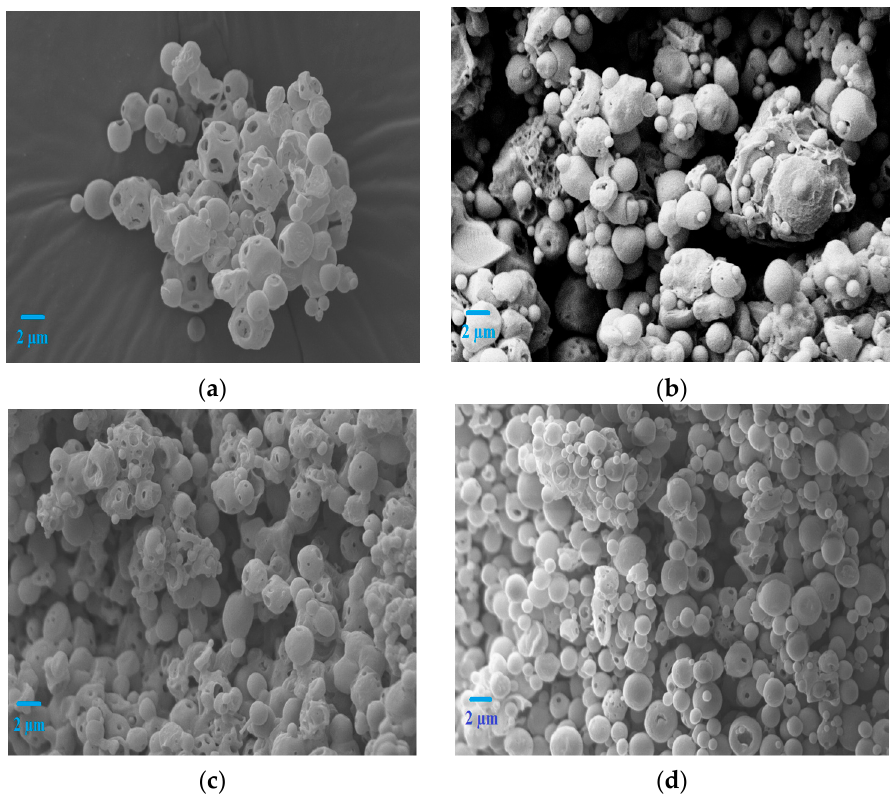
Figure 2. Scanning electron microscope (SEM) images of lysozyme loaded single-walled microspheres prepared in different formulations. ( a ) LF5; ( b ) LF6; ( c ) LF7; ( d ) LF8.